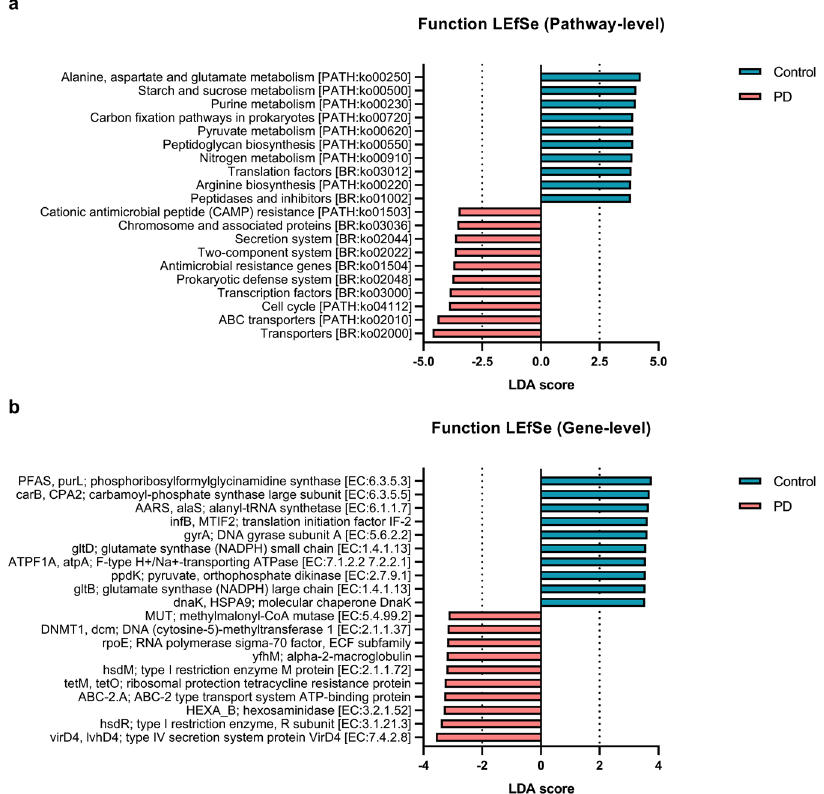
Fig. 4 Gut microbial functional pro fi les based on shotgun sequencing. a , b Comparison of gut microbial functional pro fi les between patients with Parkinson ’ s disease (PD) and healthy controls in a pathway-level, and b